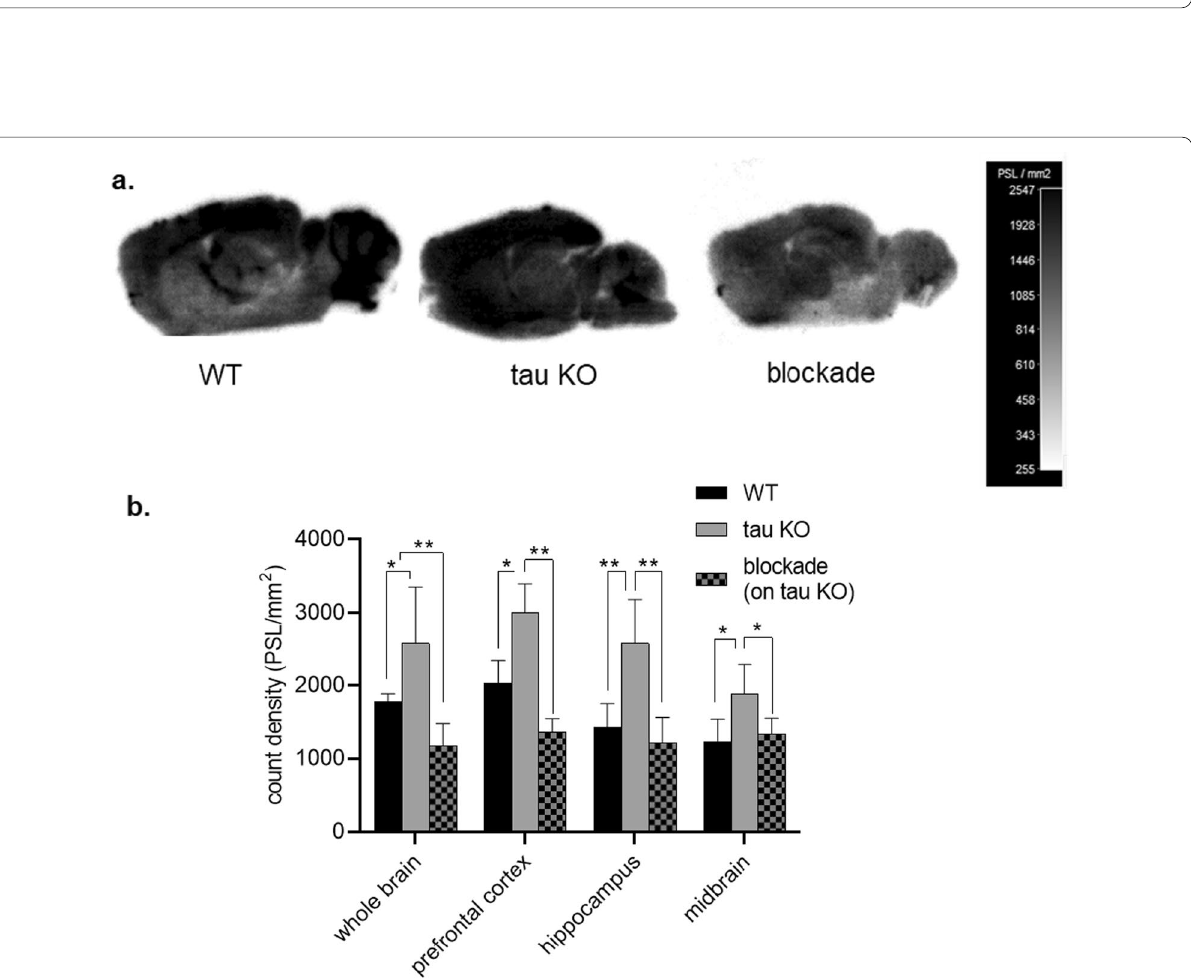
Fig. 2 Representative 0–60 min a axial and sagittal PET/CT brain images from wild type (WT) and tau knock out (KO) mice ( n whole-brain, b SUV